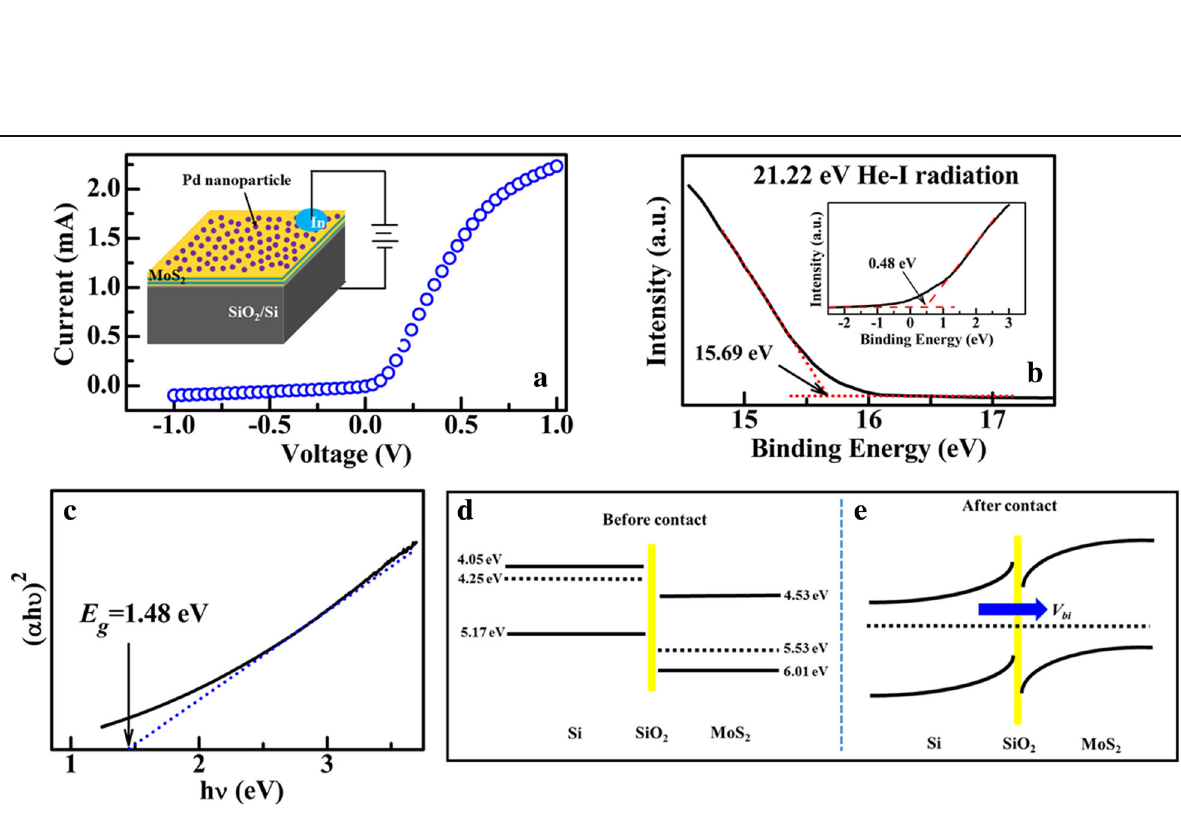
Fig. 4 a I-V characteristics of Pd-decorated MoS 2 /Si heterojunction. The inset shows the schematic illustration for the measurements. b UPS spectra of the MoS 2 layers on Si substrate. c Curve of ( α h ν ) 2 vs h ν of the MoS 2 layers. The energy band diagram at the MoS 2 /Si interface before contact ( d ) and after contact ( e )